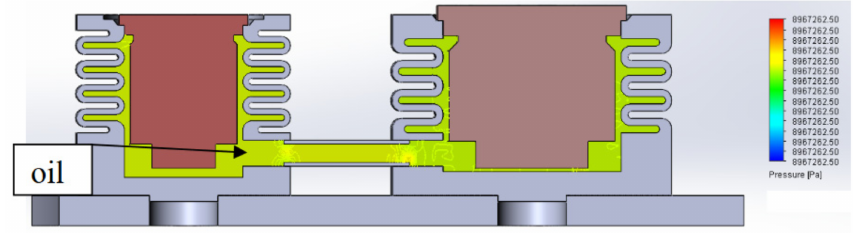
Figure 6. Diagrams of pressure inside the thrust bearing